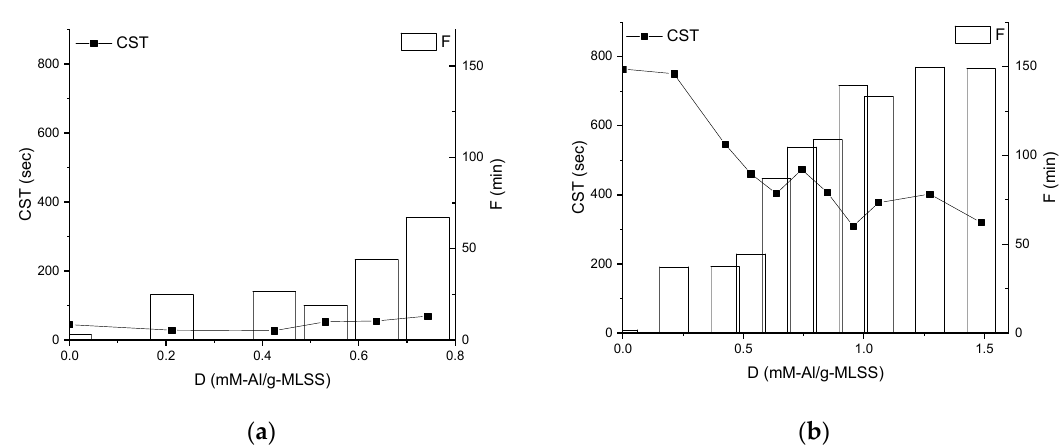
Figure 10. Influence of chemical enhancer dose on Capillary Suction Time of sediments and filtration duration of Mixed Liquors from MBBR ( a ) and IFAS ( b ).